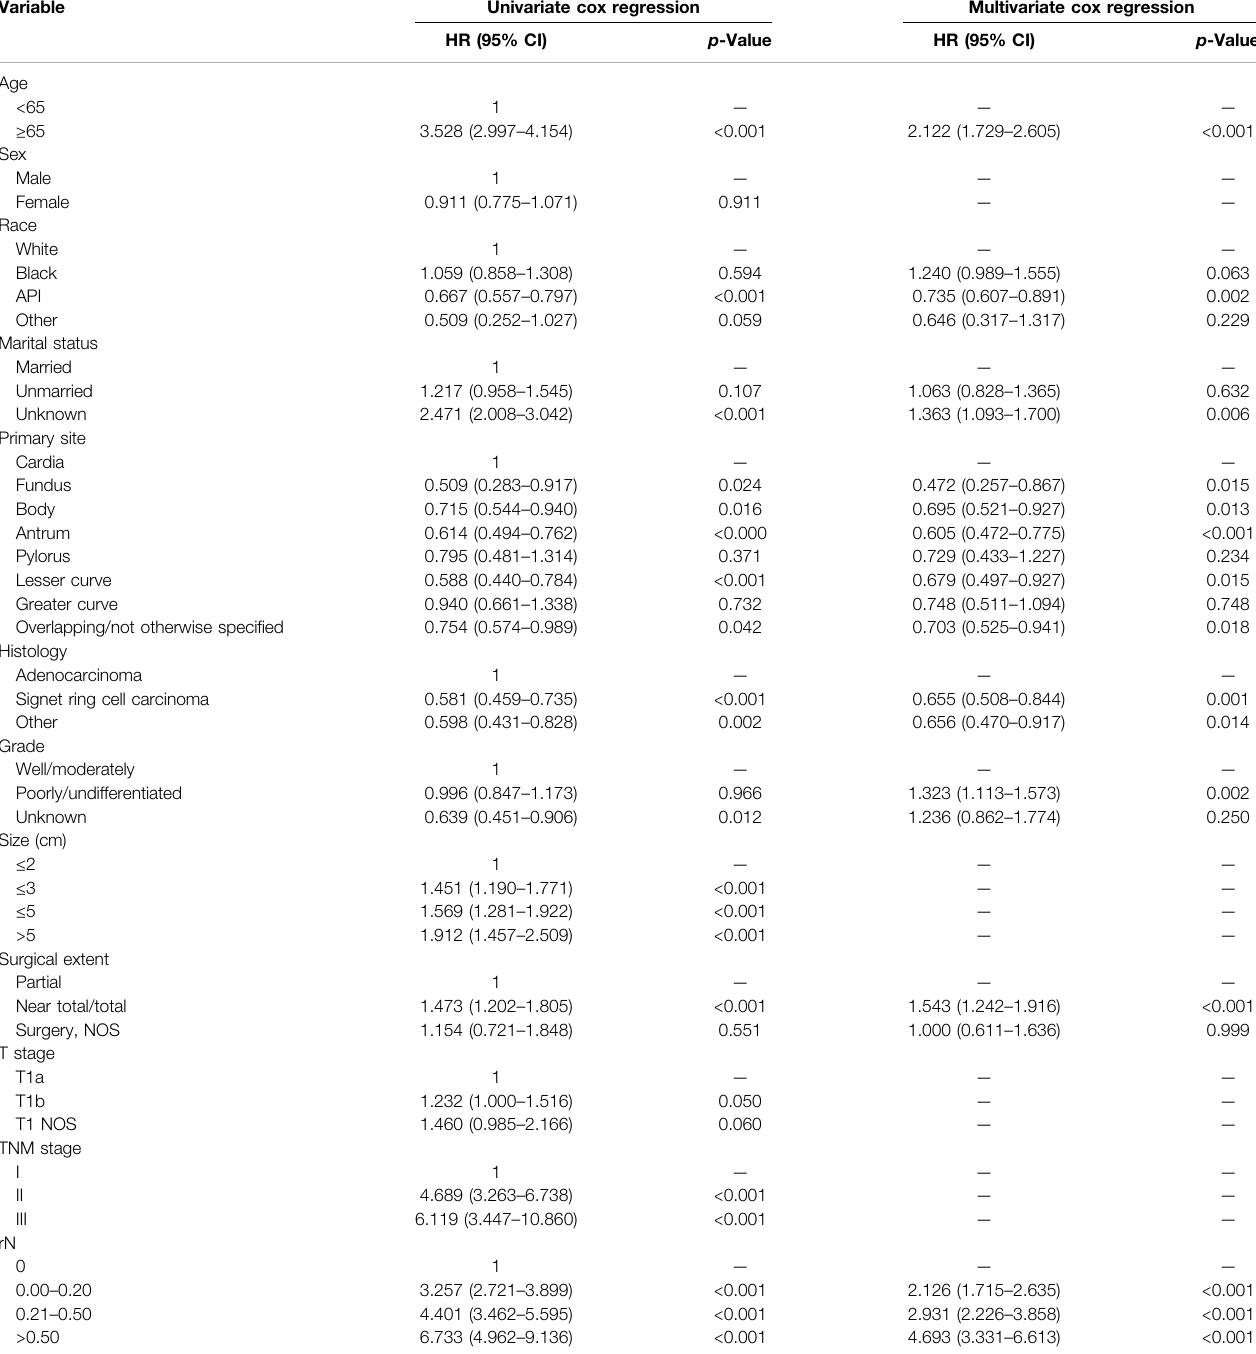
TABLE 2 | The univariate and multivariate analyses of factors associated with overall survival. Variable Univariate cox